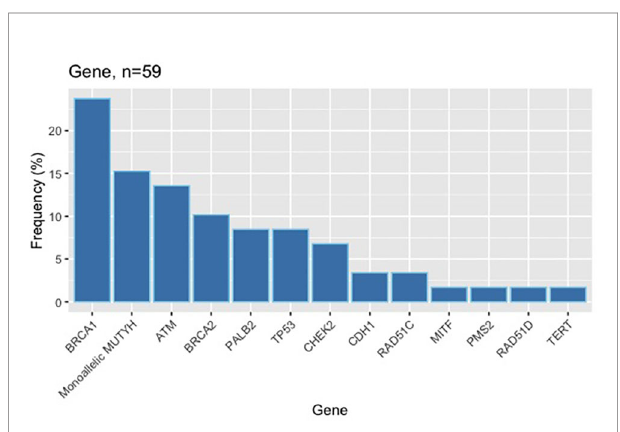
FIGURE 1 | Distribution of germline pathogenic